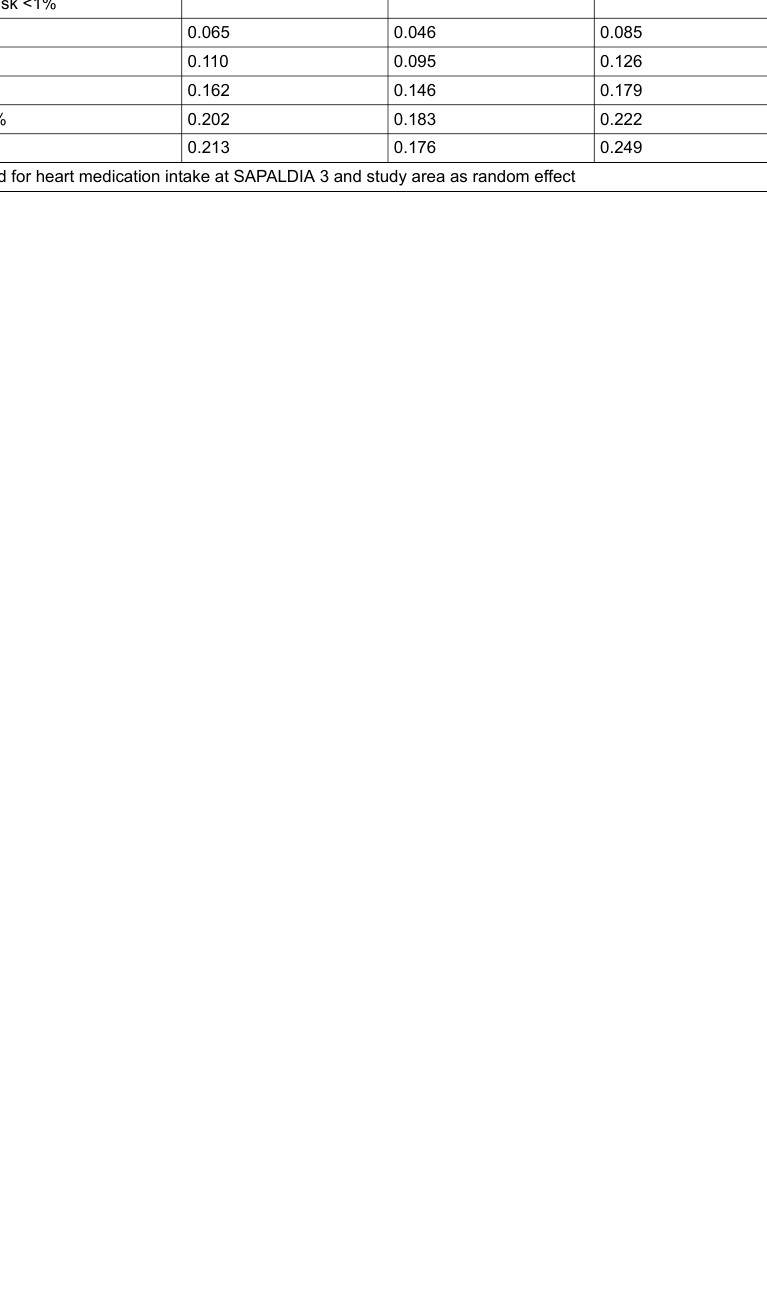
Supplemental table 4: Association between AGLA-1 and aCIMT, adjusted for heart medication intake at SAPALDIA 3. AGLA-1 risk score *